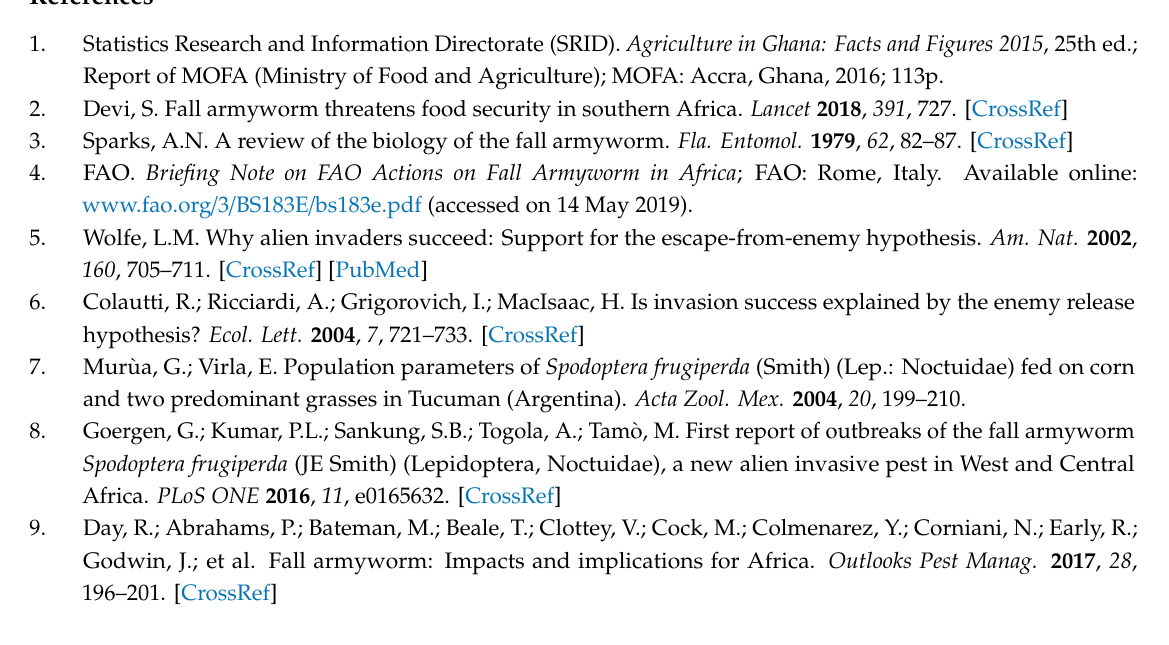
Table S1: Significant tests of hypotheses for between subjects (treatment: parasitized and unparasitized S. frugiperda larvae) e ff ects, Table S2: Significant univariate tests of hypotheses for within subject e ff